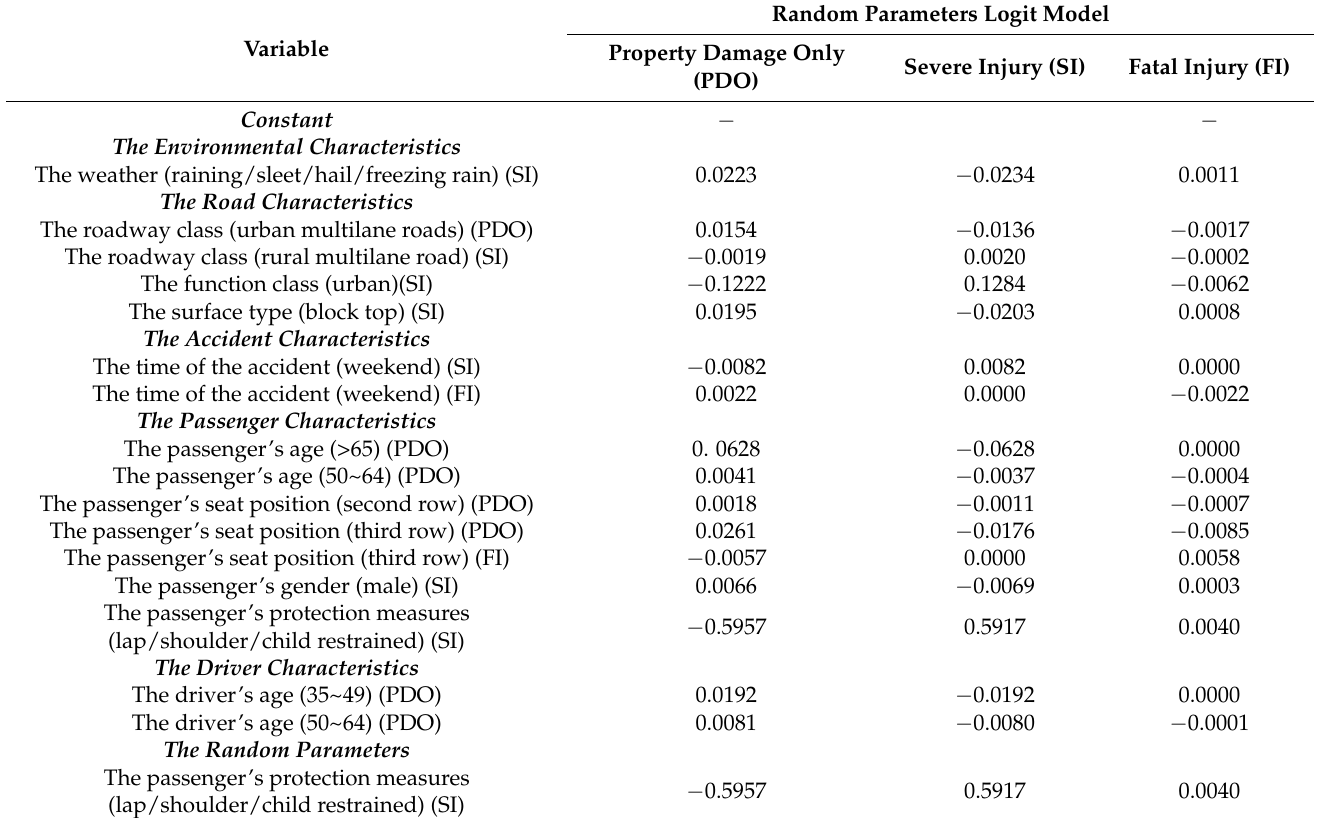
Table 5. The marginal effects of 2016 in daylight conditions with street lighting on.